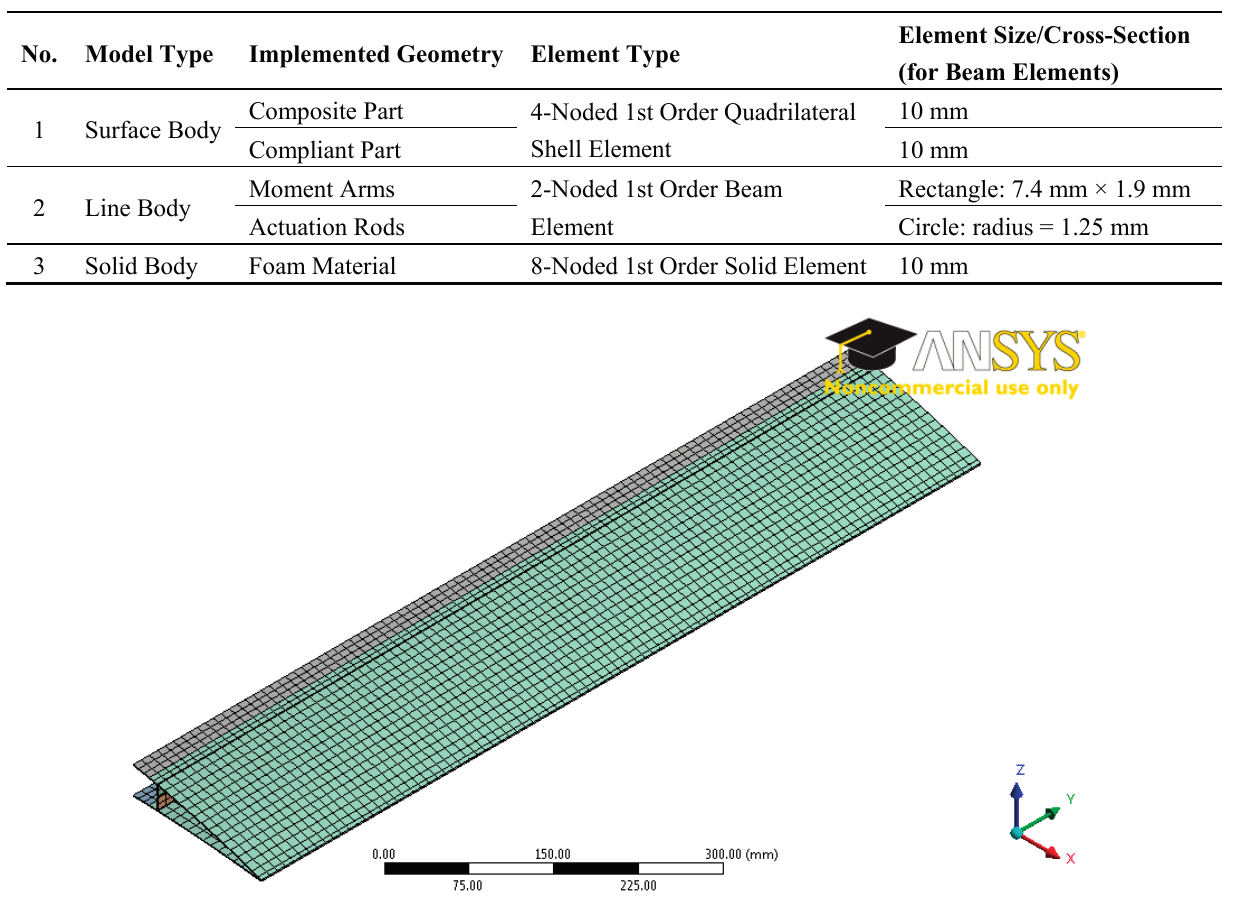
Table 5. Meshing used in the finite element modelling.